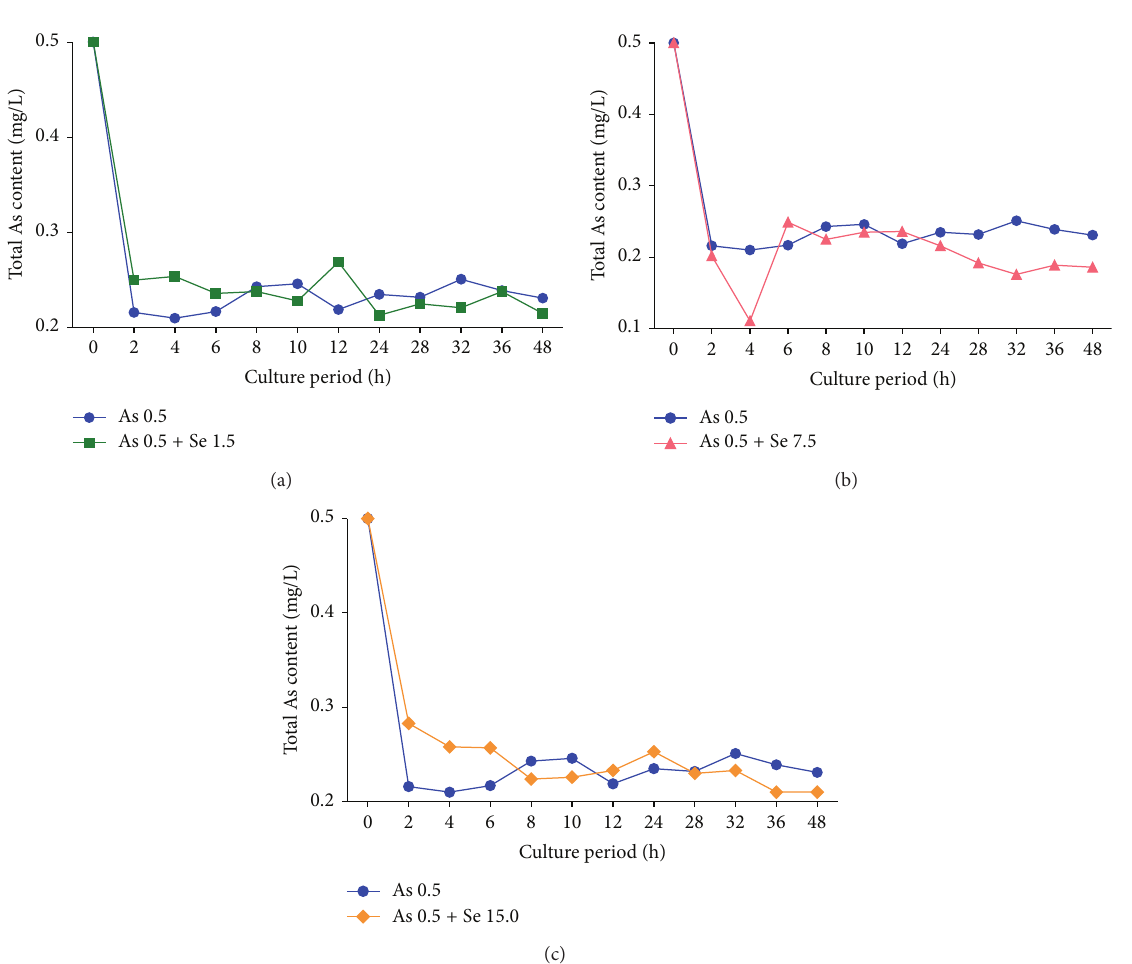
Figure 7: The content of total As in supernatant of different experimental groups. (a) As 0.5, As 0.5 + Se 1.5 (b) As 0.5, As 0.5 + Se 7.5 (c) As 0.5, and As 0.5 + Se